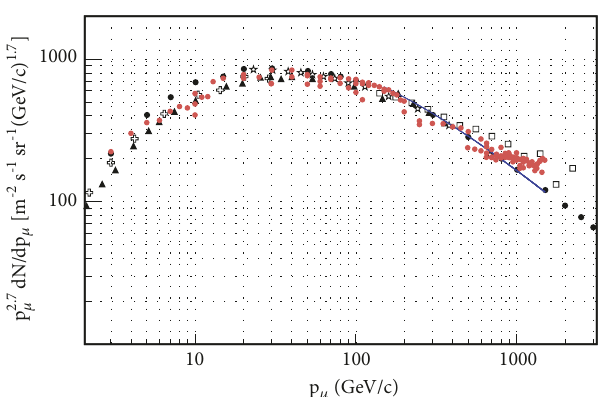
Figure 9: Muon flux generated using CORSIKA at the top of the hill (i.e. 2 k.m. above the sea level) with primary protons in energy range 1-20 TeV(brown dots) and its comparison with the existing experimental fluxes ( ‰ [2], △ [7], +[8], ◻ [9], ∙ [10]) and the flux (solid blue line) from [11].